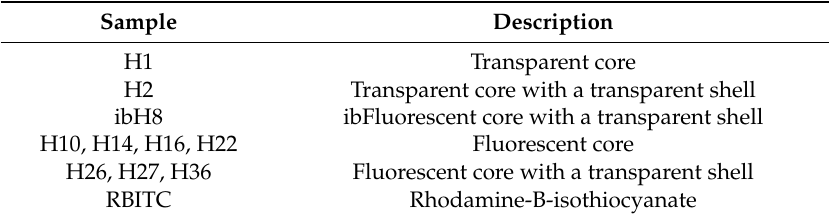
Table 1. Description of the nanoparticle (NP)